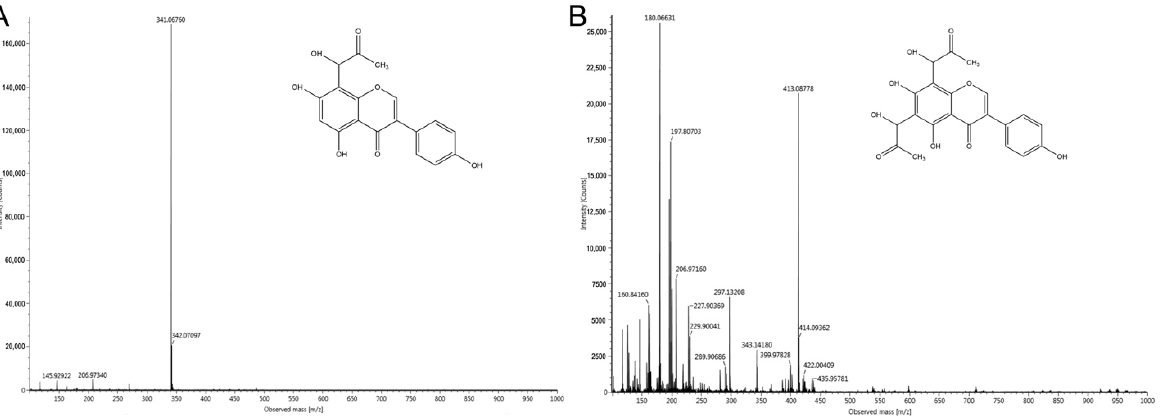
Figure 9. Tandem MS spectra of mono-MGO and di-MGO adducts of genistein. ( A ) MS spectrum of mono-MGO adduct; ( B ) MS spectrum of di-MGO adduct.